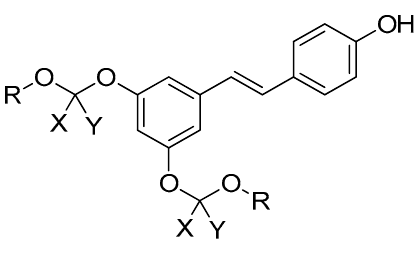
Figure 7. Chemical structures of acetal derivatives of RSV ( 11 – 13 ).